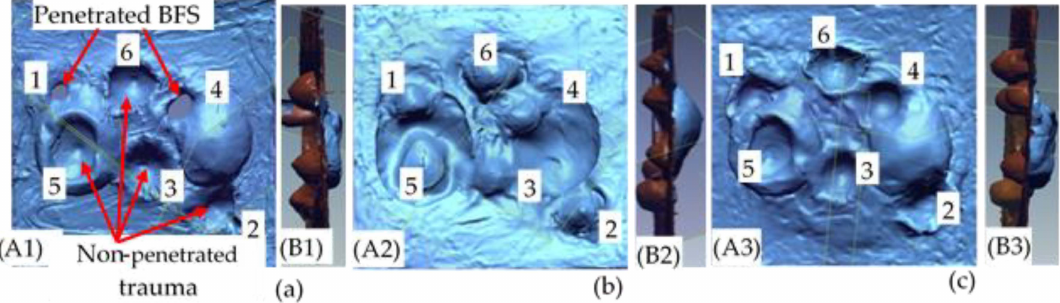
Figure 7. Scanned pictures of trauma indentation on the backing material for ( a ) sample 3D-40-8B:0S; ( b ) sample 3D-40-8B:4S and ( c ) sample